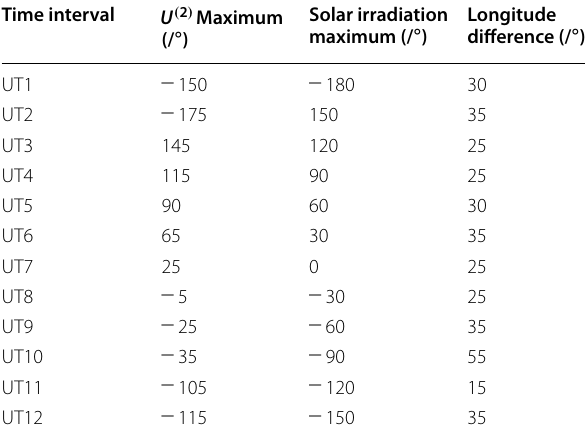
Table 2 The longitude position of the maxima of U ( 2 ) and solar irradiation and longitude differences in each UT interval Time